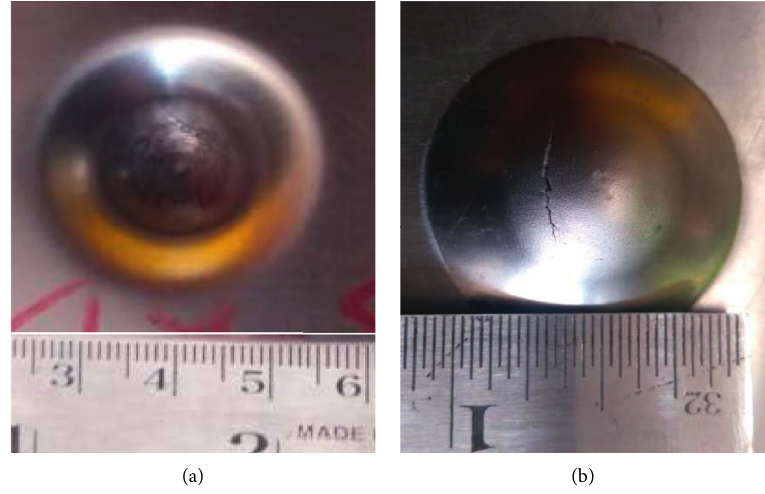
Figure 4: Photo image of the CP-Ti material after ball-punch mechanical deformation. (a) Back view. (b) Front view.